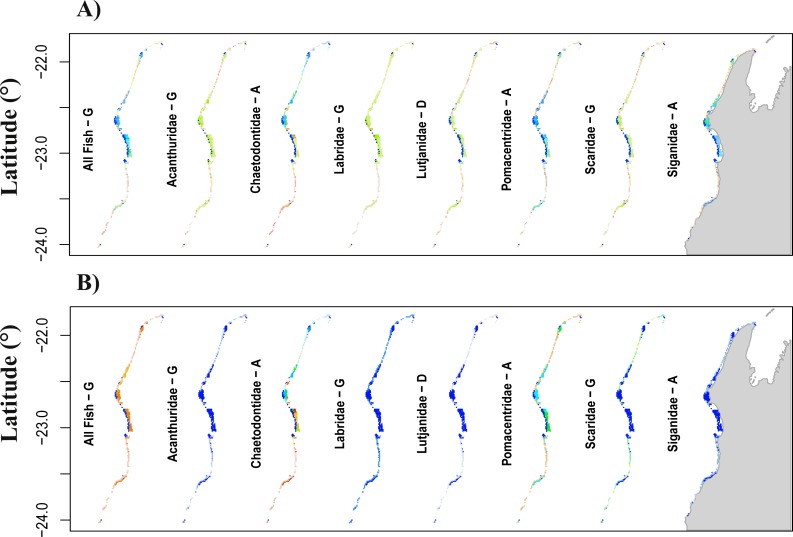
Prediction of total fish abundance (Ntotal) and fish abundance by fish family to Ningaloo Reef (NR) by the transferred models from the GreatBarrier Reef (GBR).Results for each family shown for the scenario resulting in best ‘%high-versus-low’ indicated with letter from (A to G) as per Table 5 (refer to Fig. S4 for predictions from all the transferred GBR scenarios to NR). Colour scheme shown in Fig. 1 applies here with: (A) showing maximum and minimum values for each map independently, and (B) reflecting ranges of values across all maps. For predicted minimum and maximum abundance values for each scenario refer to Tables 2 and 4. Grey area represents the Northwest of Western Australia, longitude: 113.7° to 114.5°E.